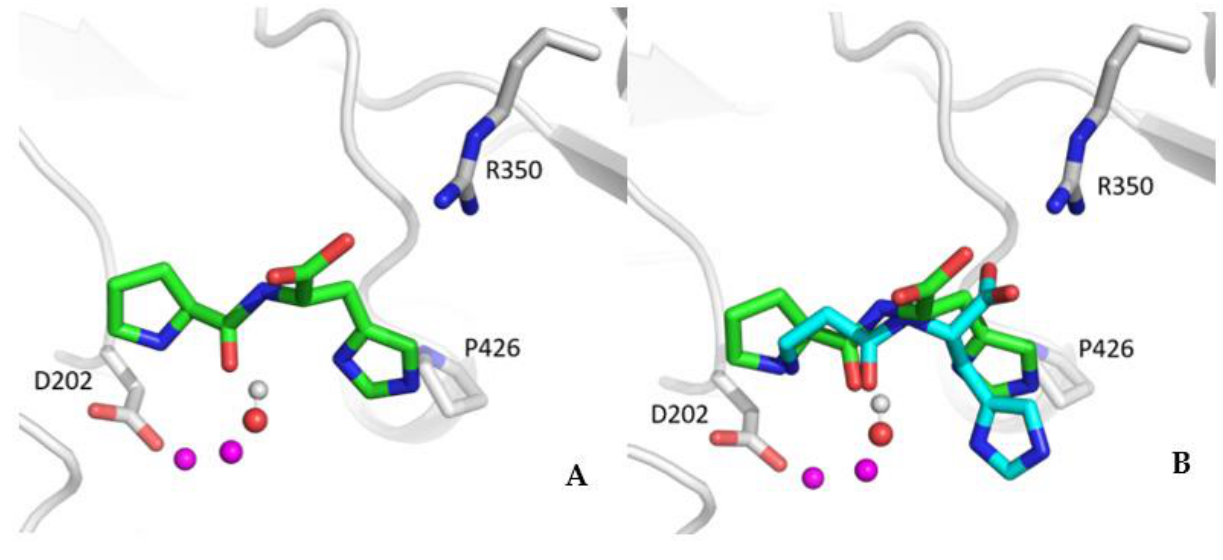
Figure 4. Main interactions stabilizing the putative complex between CN1 and Pro-His (4 A ) and comparison with the corresponding complex for L -carnosine (in azure, 4 B ).